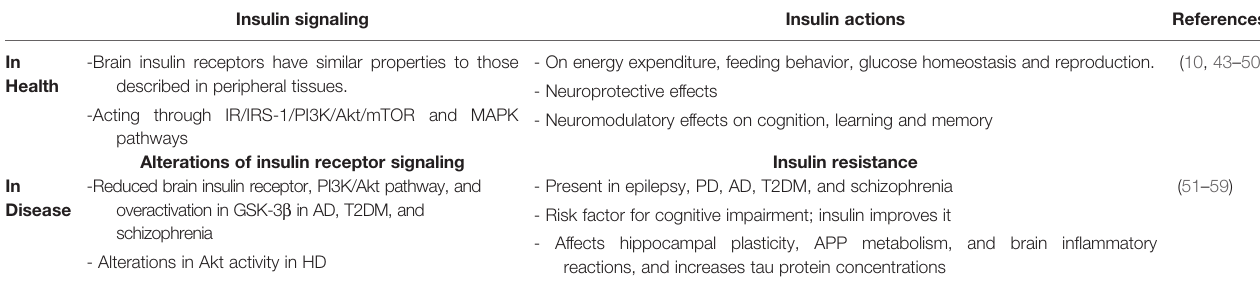
TABLE 2 | Some aspects of physiological and pathophysiological metabolism of insulin in the